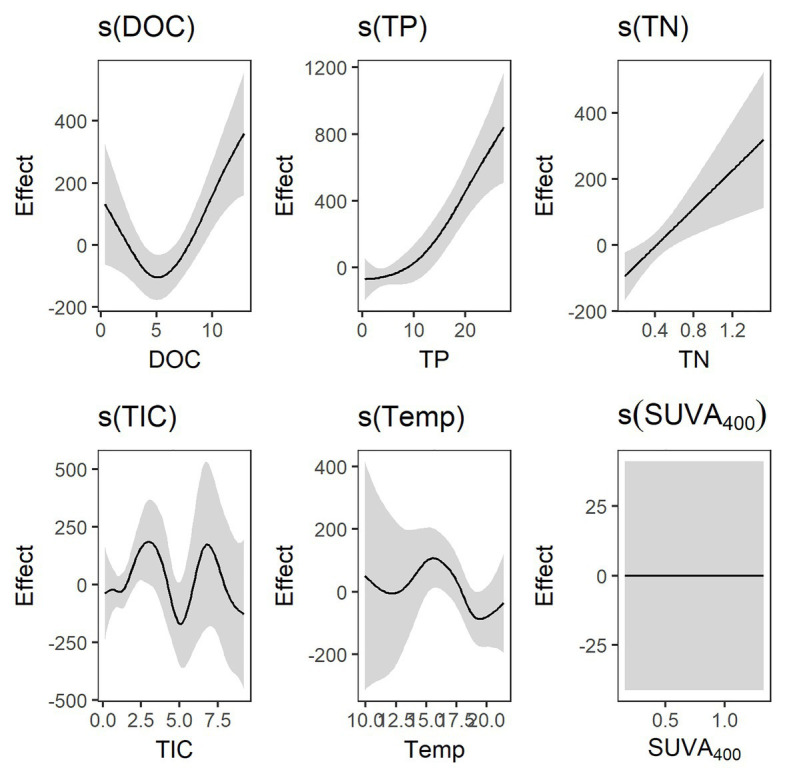
Result plot of the generalized additive models (gams) predicting total carbon dioxide (CO2) production (Ftot; mg C m−2 d−1). The effect of DOC (mg L−1) was strong and clearly unimodal with a minimum around 5 mg L−1. Total phosphorus (TP; μg L−1) and total nitrogen (TN; mg L−1) had strong linear effects. The effects of total inorganic carbon (TIC; mg L−1) and temperature (°C) were weak, while SUVA400 (L mg-C−1 m−1) had no effect on total CO2 production.